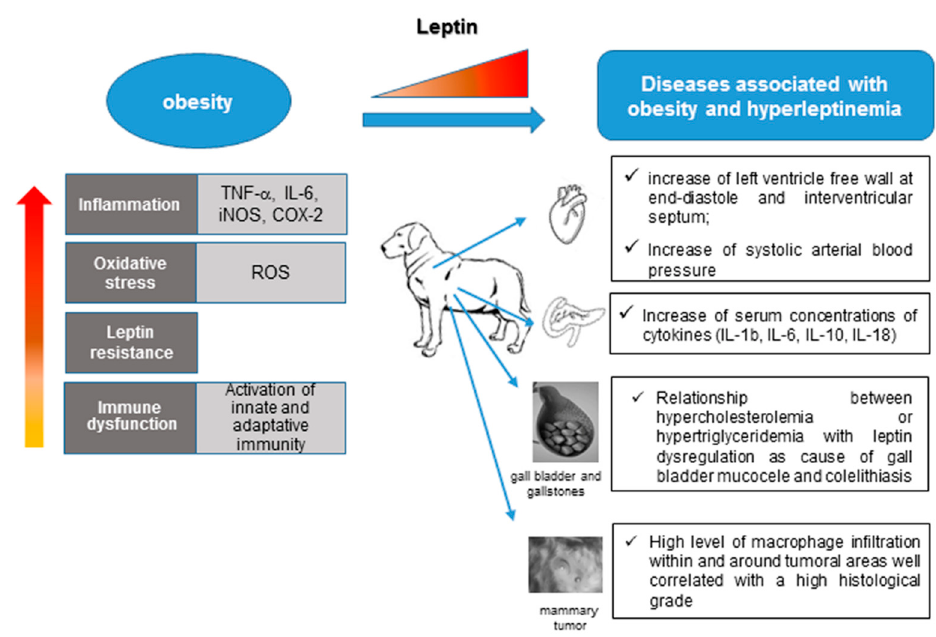
Figure 3. Obesity in dogs and diseases associated with hyperleptinemia.